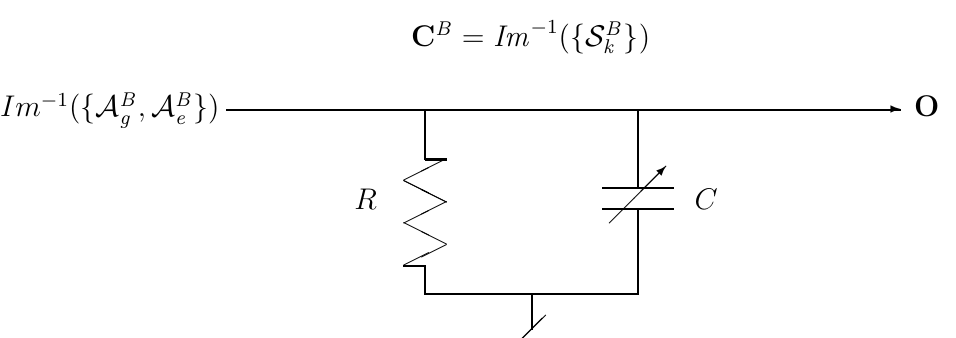
Figure 7. Simple circuit model of decoherence in an information channel Im